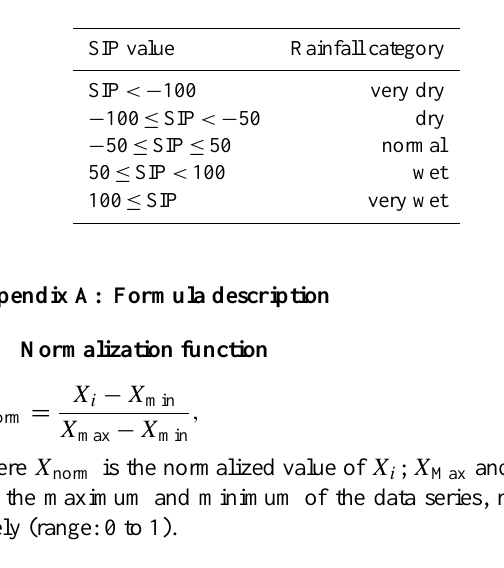
Table A1. Rainfall categories base on SIP